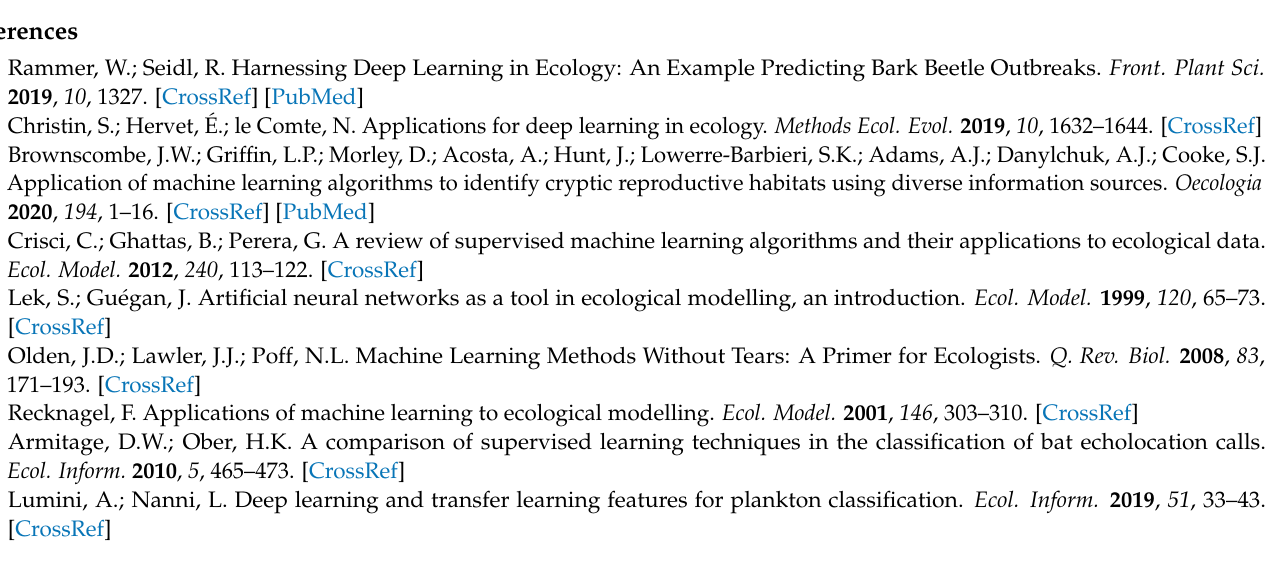
between groups in habitat heterogeneity. Table S4. Showed the results of Kolgomorov-Smirnov test between distributions of beta diversity indices after the resampling procedure. The stars represents rules from presence/absence data mined with frequent pattern growth algorithm, in 2014 and 2015. The association rules highlight the frequency and the correlations between taxa co-occurrences. For each rule were reported the quantitative measures of interestingness: support, confidence and lift. Figure S4. Frequent pattern trees (FPt) for the community structure in Cluster 1 (a) and 2 (b) in 2014 and in Cluster 1 (c) and 2 (d) in 2015. Each node represents a specific taxon and its absolute frequency (number of ponds where the taxon was found). The branches join the co-occurrence of